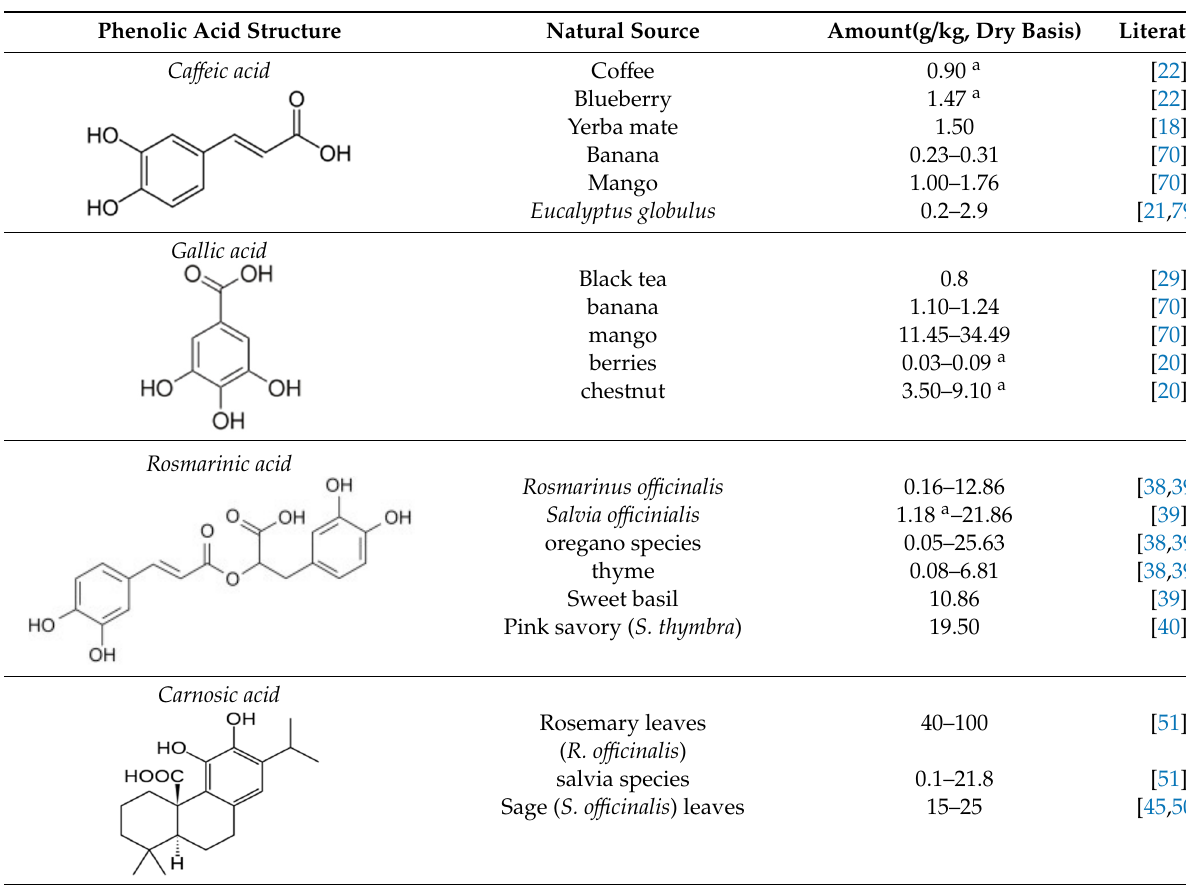
Table 1. Natural sources of the examined phenolic acids along with the most recent literature references.